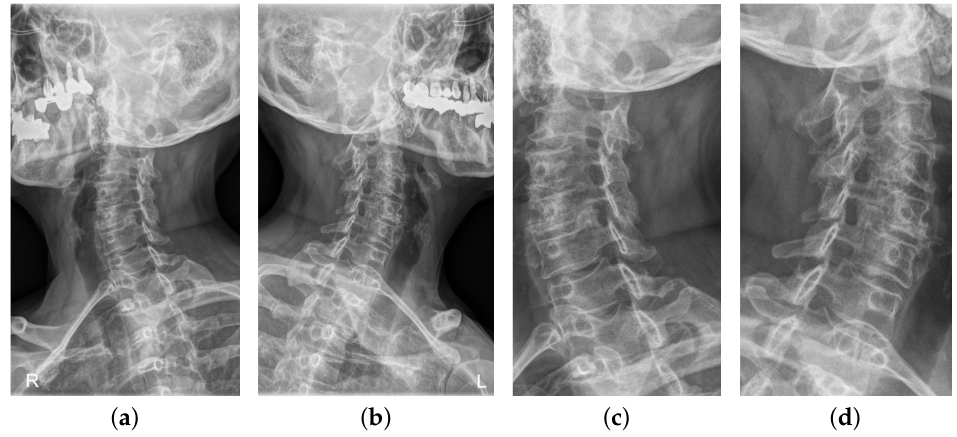
Figure 2. Results of ROI crop using YOLOv5. ( a ) right original oblique view, ( b ) left original oblique view, ( c ) right ROI cropped oblique view, and ( d ) left ROI cropped oblique